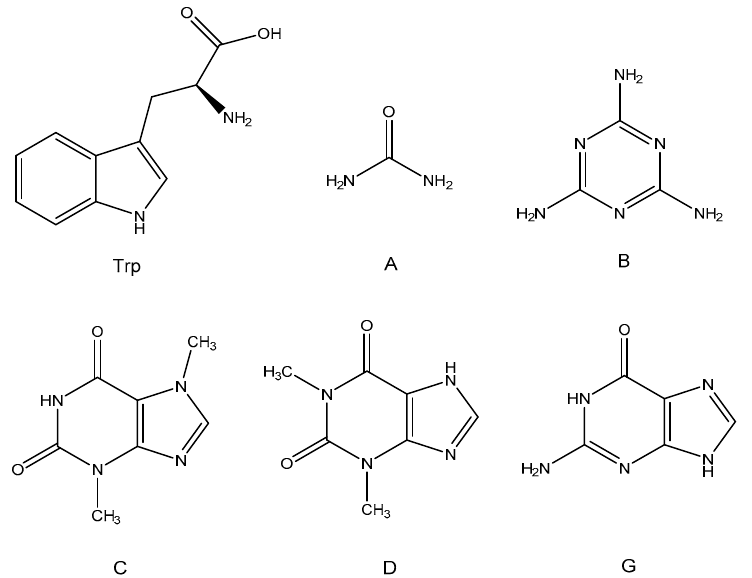
Figure 1. Molecular structures of tryptophan (Trp), urea ( A ), melamine ( B ), theobromine ( C ), theo- phylline ( D ), and guanine ( G ).